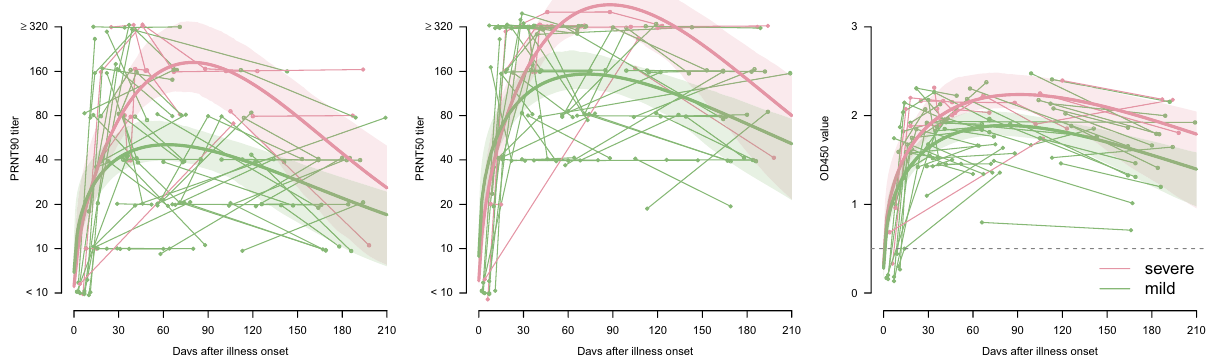
Fig. 3 Longitudinal antibody responses (PRNT 90 , PRNT 50 , and ELISA) in COVID-19 patients by days after illness onset and severity, Hong Kong. Data from 61 patients with multiple samples for PRNT 90 and PRNT 50 antibody titers and 54 patients with multiple samples for ELISA. Small random noises were added to the PRNT 90 and PRNT 50 titers for better presentation. The thick lines showed the fi tted values and shaded areas showed the 95% con fi dence intervals. Neutralization and ELISA assays were carried out in